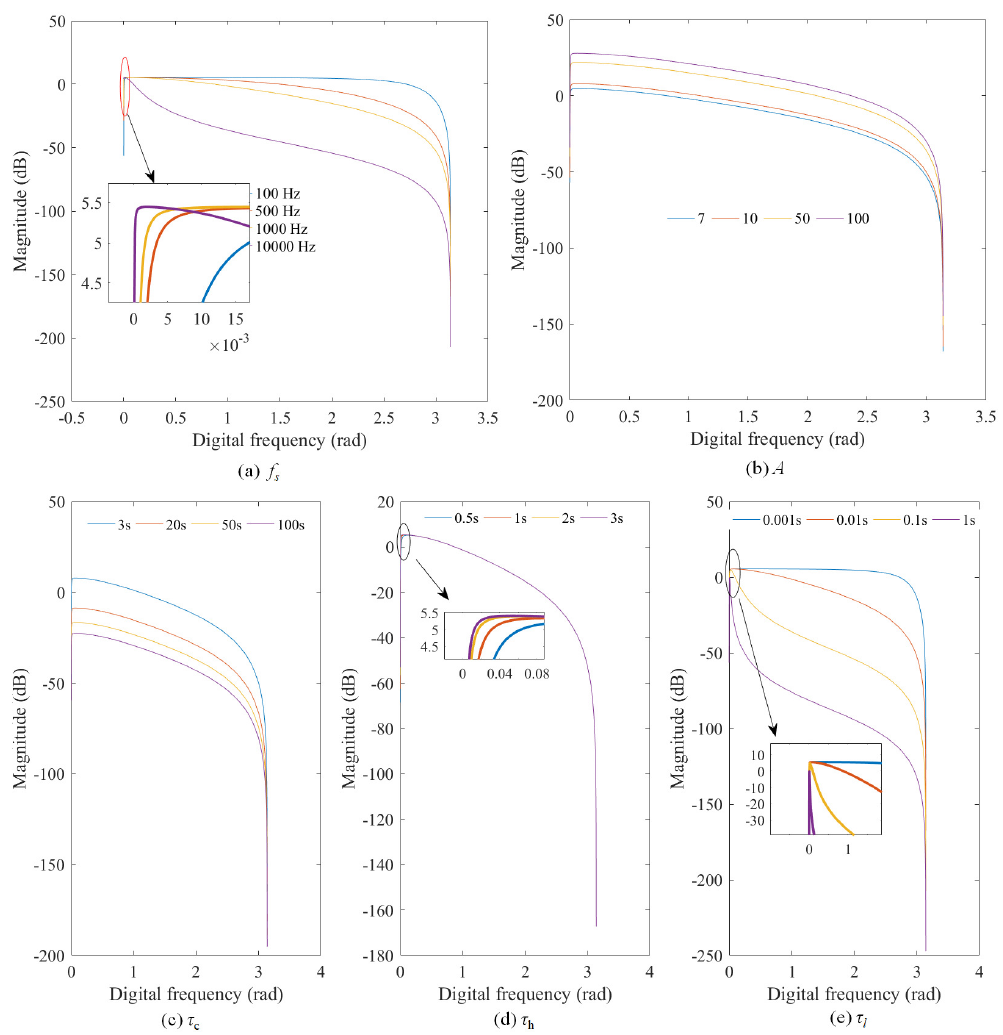
(cid:12) (cid:12) (cid:12) (cid:12) ( e j ω ) (cid:12) H (cid:12) with different parameters: ( a ) f s , ( b ) A , ( c ) τ c , ( d ) τ h , ( e ) τ l